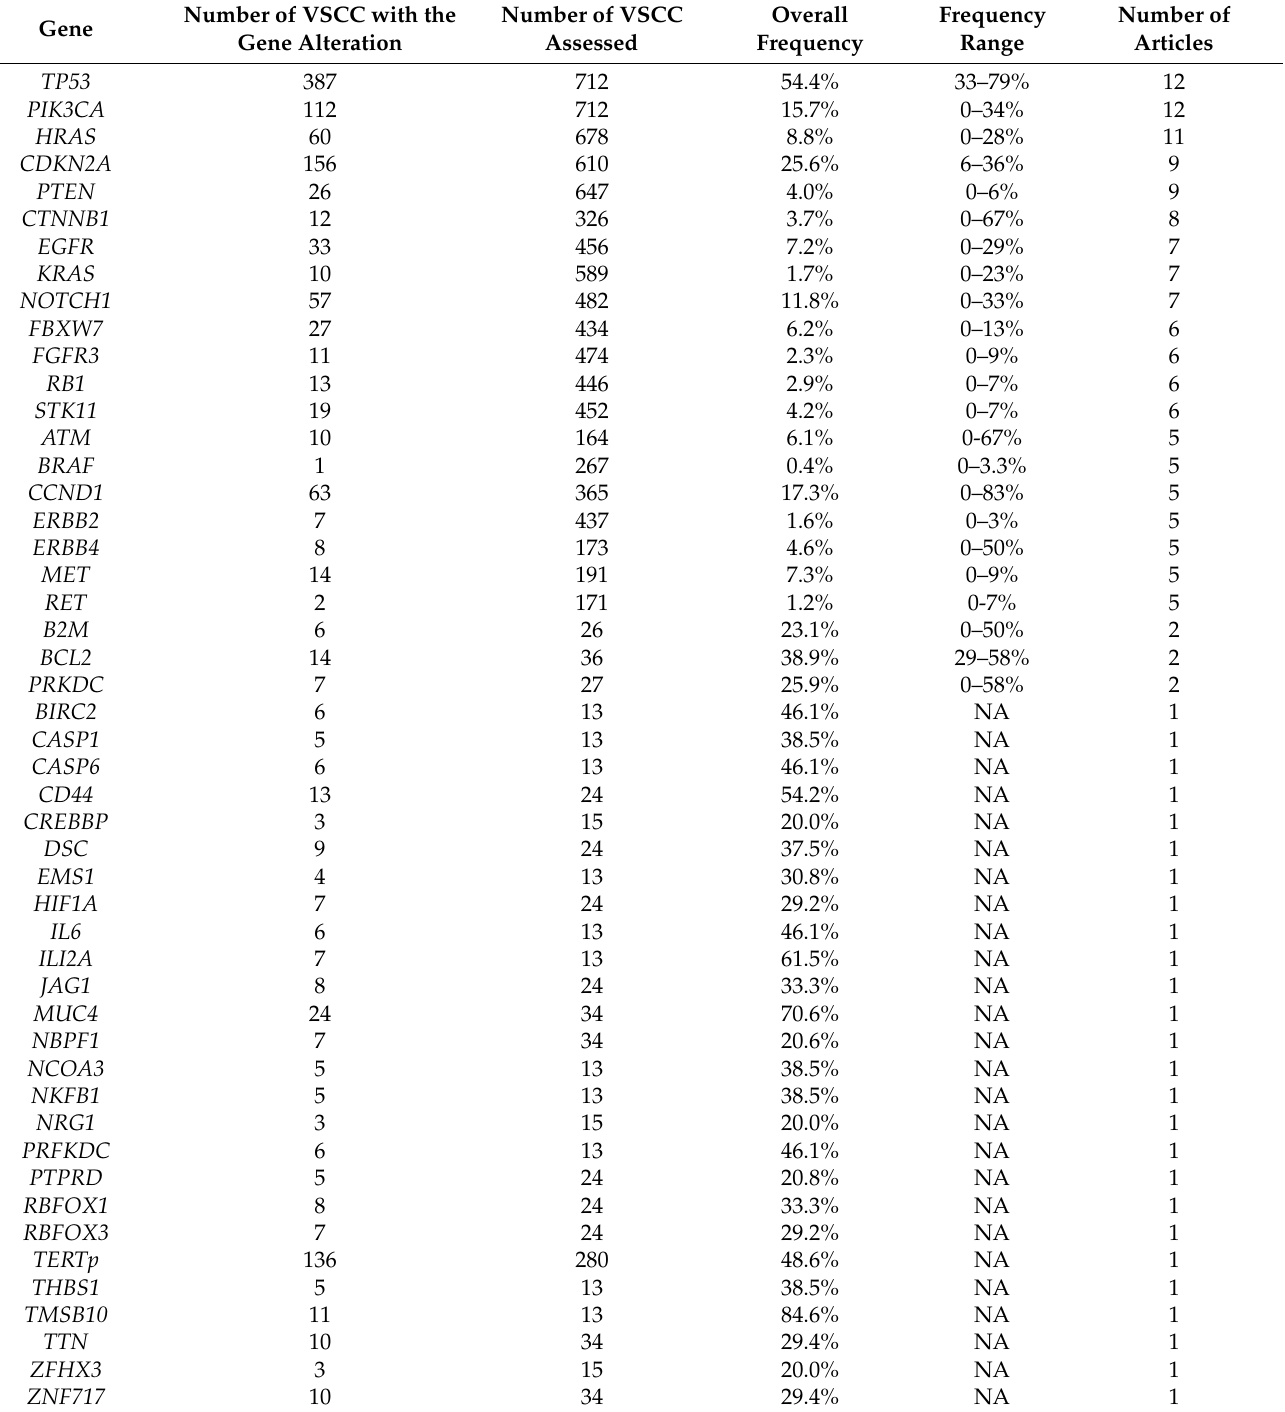
Table 2. Frequencies of identified alterations in individual genes stratified by the number of articles that performed molecular analyses in vulvar squamous cell carcinomas